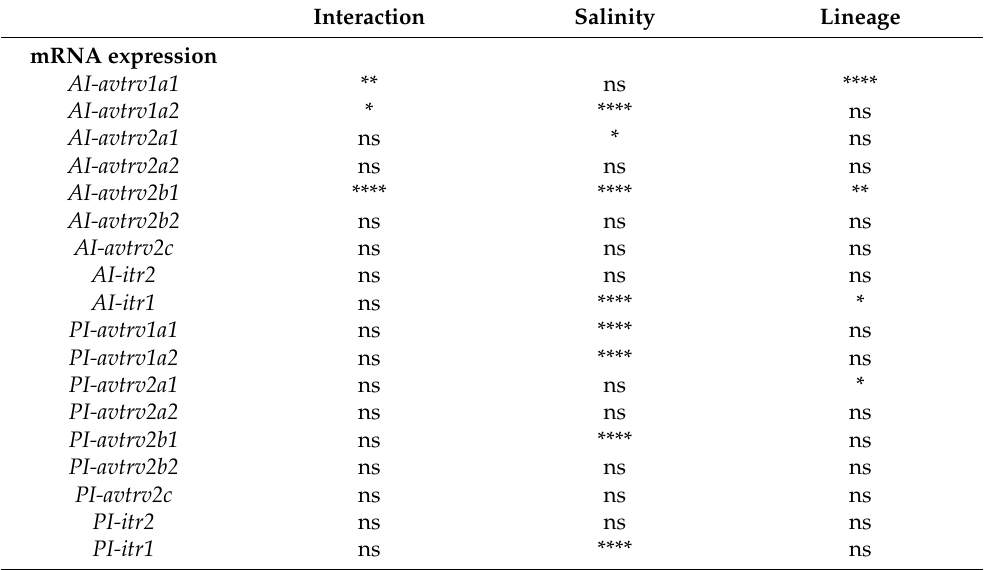
Table 2. Two-way ANOVA results of data with salinity and lineage as the main factors. ns: not significant, * p < 0.05, ** p < 0.01, **** p < 0.0001. N = 11 per condition.